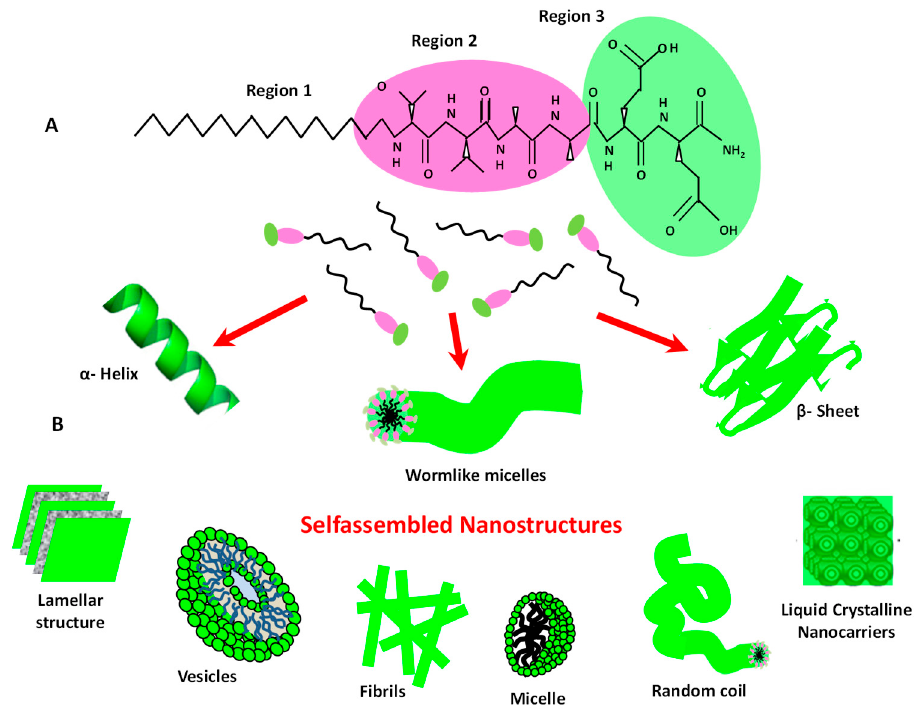
Figure 13. Typical (3 regions) structure of a peptide amphiphile ( A ). Example of the possible nanostructures generated by the peptide amphiphiles self-assembly ( B nanostructures generated by the peptide amphiphiles self-assembly ( B ).